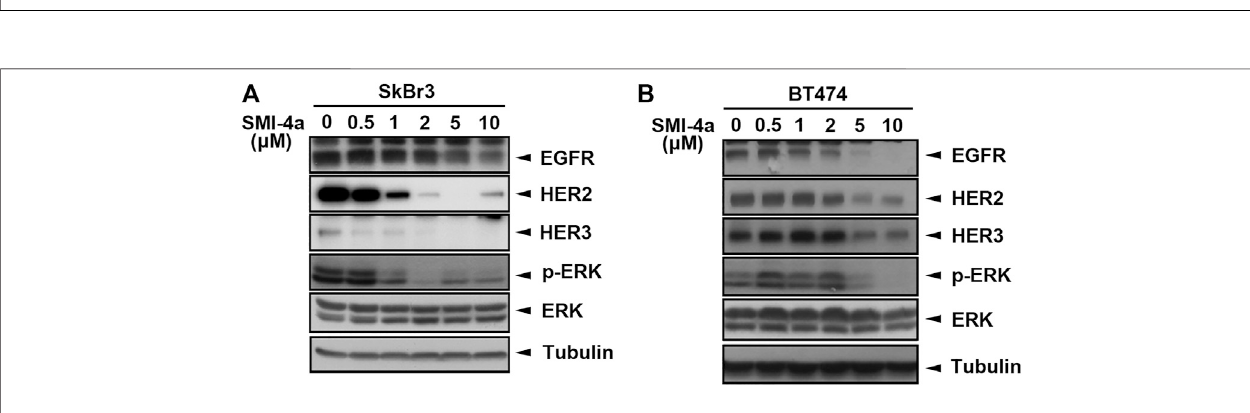
Frontiers in Pharmacology |